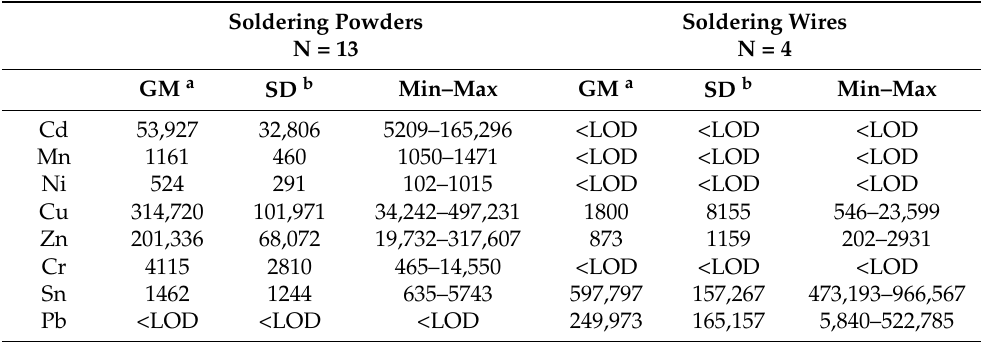
Table 3. PTE levels (ppm) in soldering powders and wires. Limeira, Brazil,